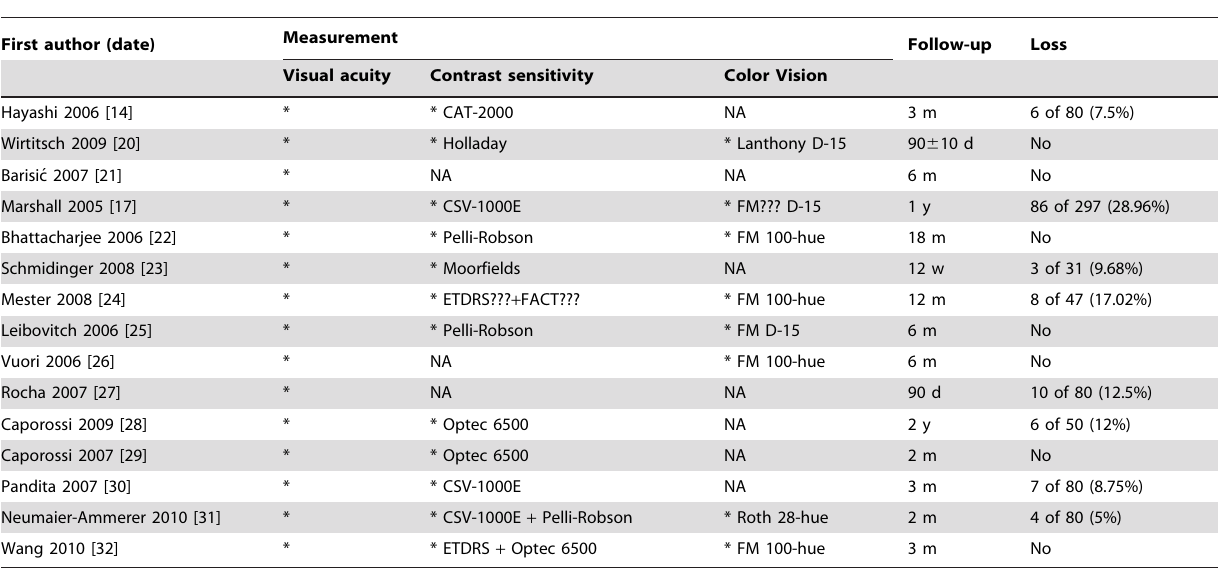
Table 2. Characteristics of RCTS (n =15) included in the meta-analysis.